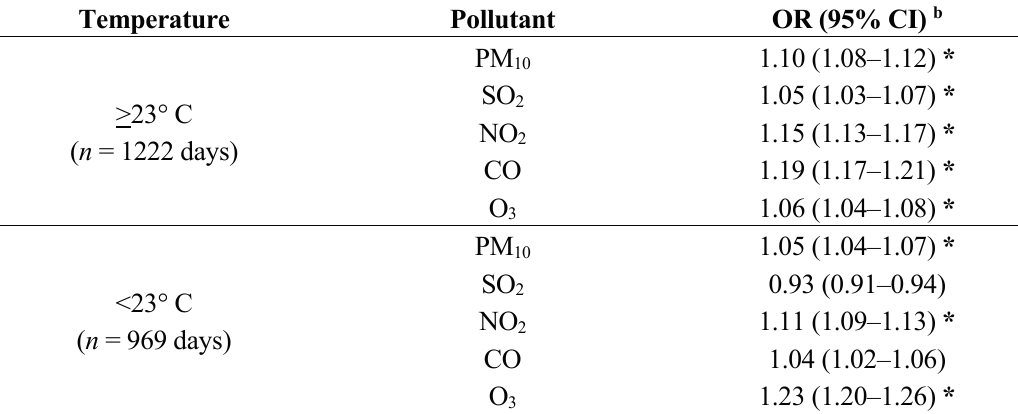
Table 3. Odds ratio (OR) and 95% confidence interval (CI) for daily headache visits for each interquartile range increase a in single-pollutant model in Taipei, Taiwan,